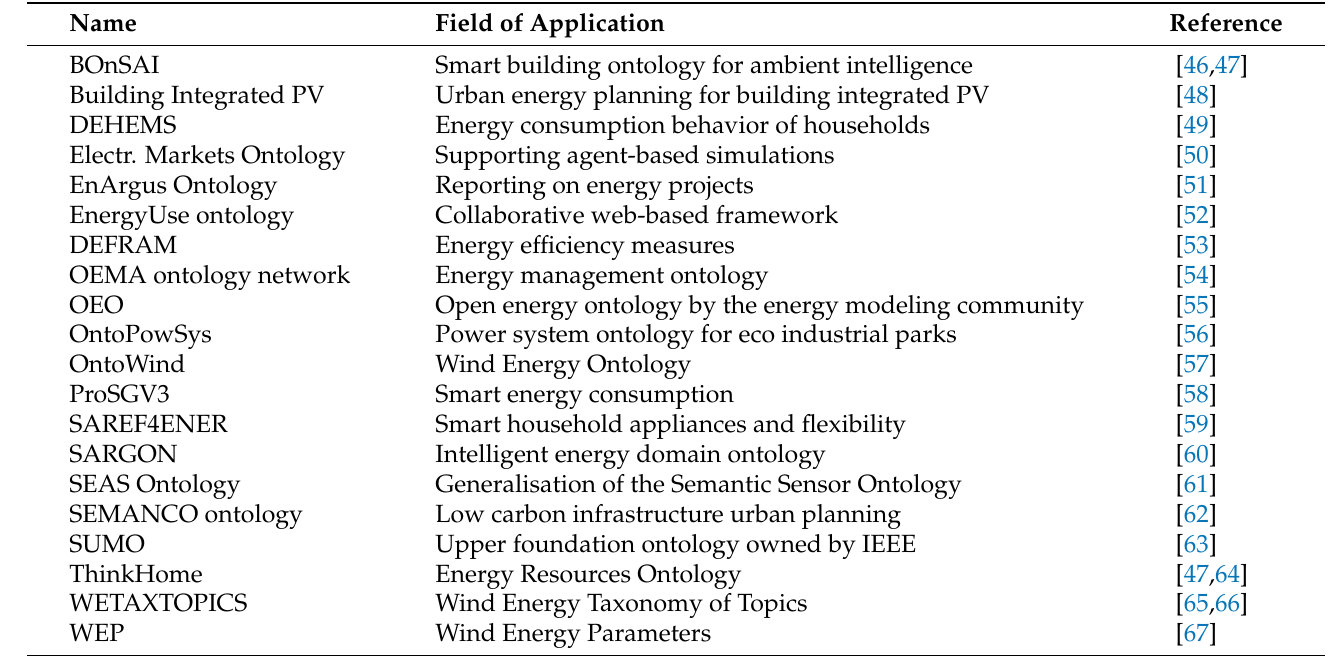
Table 1. Ontologies identified in the energy